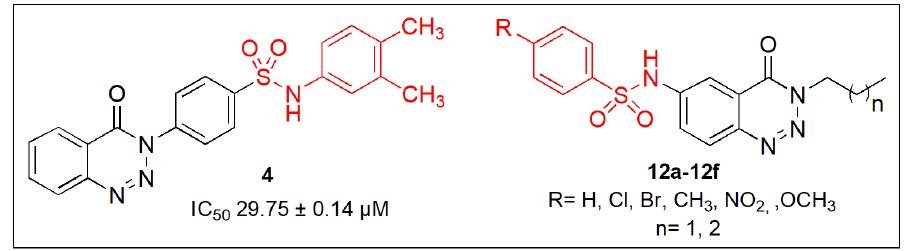
Figure 2. Design of new 1,2,3-benzotriazin-4(3 H )-one sulfonamides 12a – 12f.